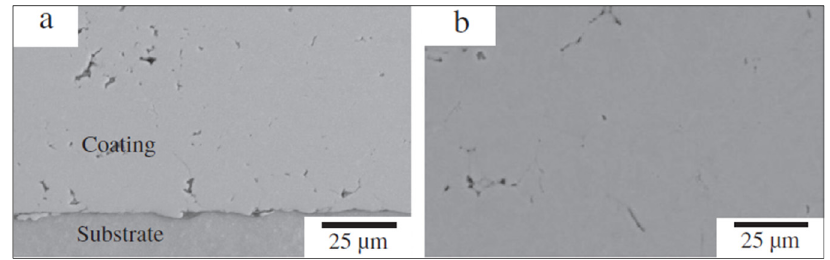
Figure 11. Scanning electron microscopy (SEM) micrographs of cold sprayed Al deposit on as-sprayed ( a ) cross plane and ( b ) normal plane [41]. Copyright 2006 Elsevier.